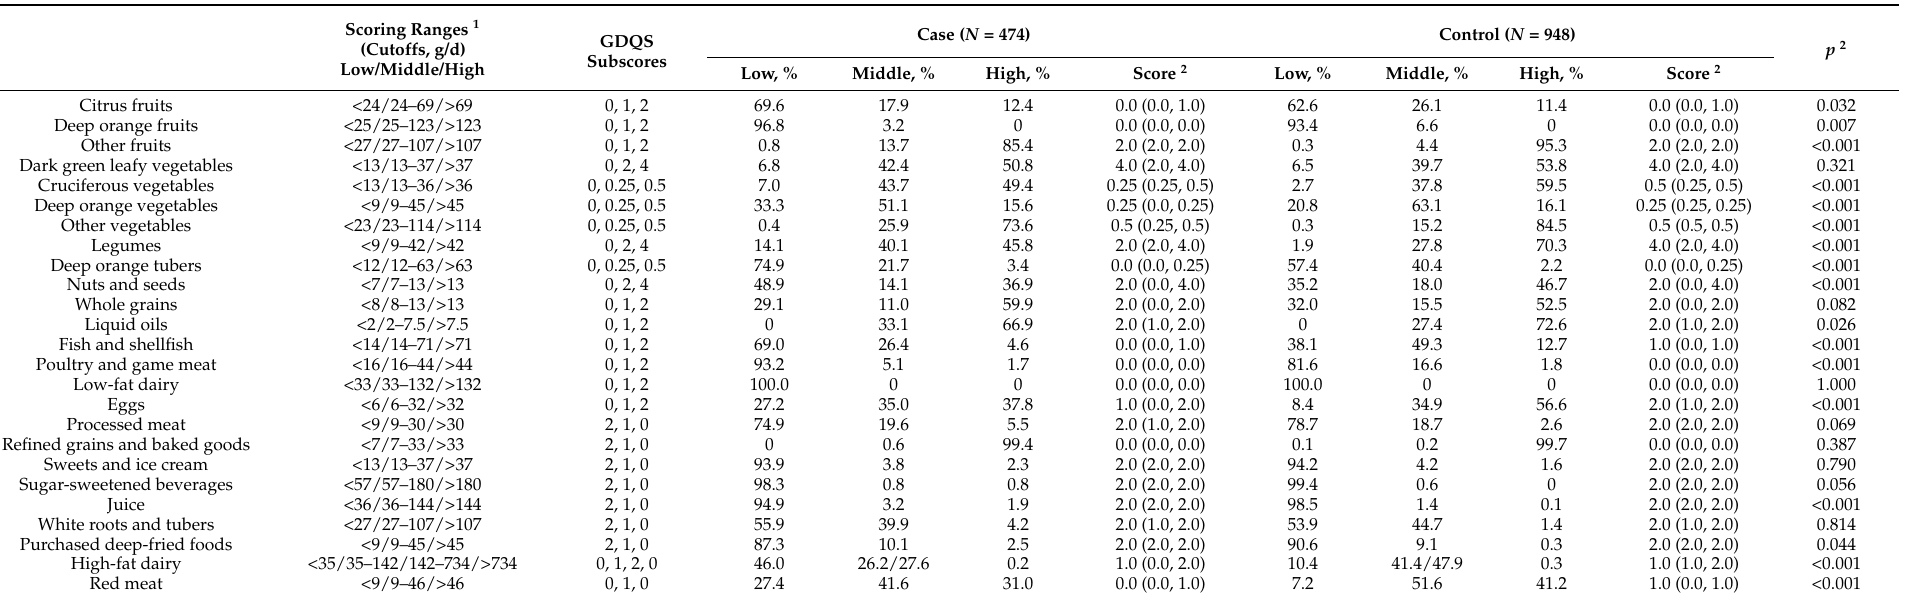
Table 2. The distribution of food components in the Global Diet Quality Score among cases and